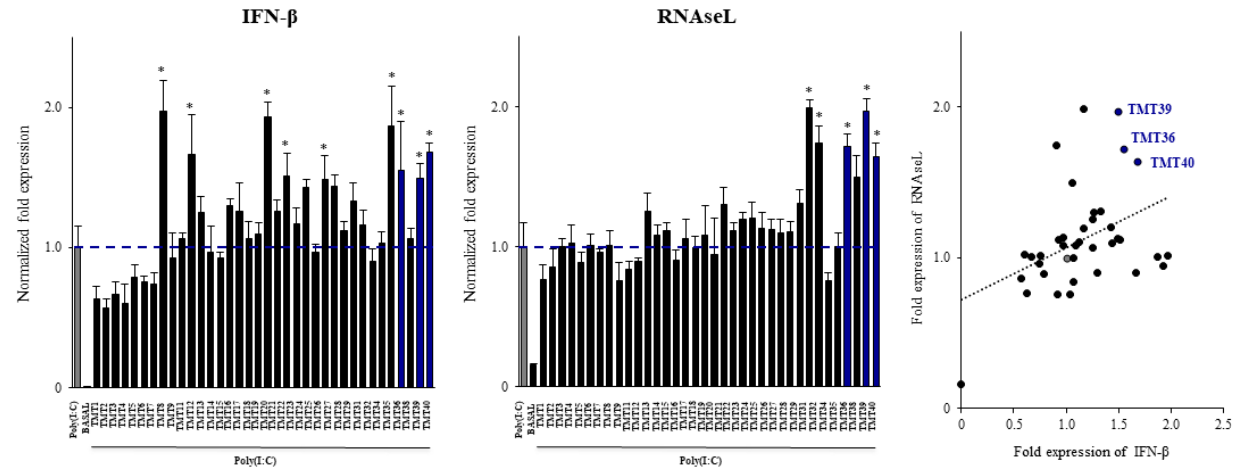
Figure 2. Effect of viable lactic acid bacteria strains on the expression of interferon and interferon- induced antiviral genes in porcine alveolar macrophages after the activation of Toll-like receptor 3 (TLR3). Alveolar macrophages were stimulated with viable bacteria and then challenged with the TLR3 agonist poly(I:C). The expression of IFN- β and RNAseL were analyzed by qPCR after 12 h of TLR3 activation. Non-bacteria treated alveolar macrophages challenged with poly(I:C) were used as controls. The results represent data from three independent experiments. Significant differences were observed when compared to poly(I:C)-challenged control porcine alveolar macrophages. * ( p < 0.05). Correlation between the fold expression of IFN- β and RNAseL by a linear regression function was performed.